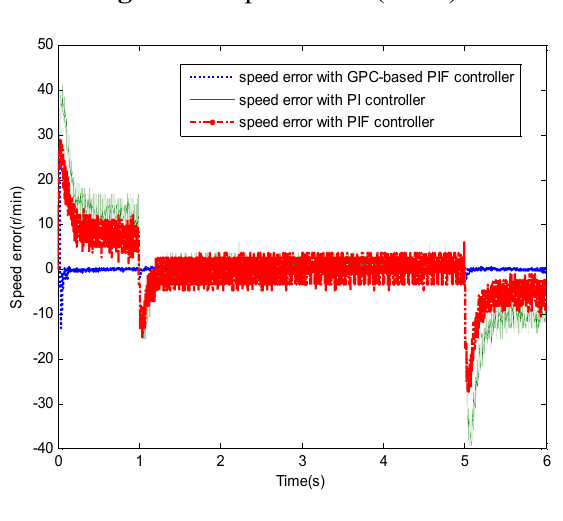
Figure 11. Speed error (test 2).